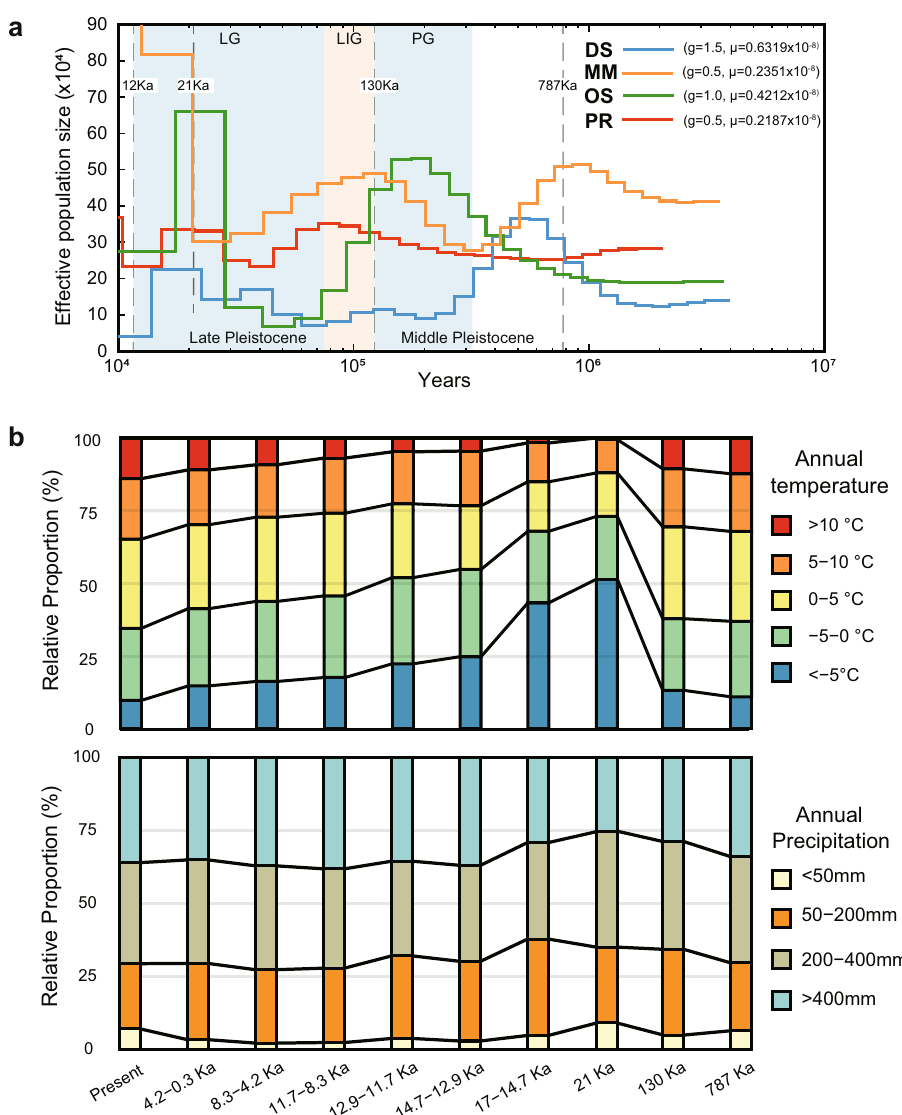
Fig. 5 Demographic history of the four desert rodents during historical climate changes. a Effective population sizes of the four desert rodents reconstructed using the PSMC model (g, generation time, years; μ , neutral mutation rate per generation). The period of the Penultimate Glaciation (PG, 330 – 130 ka), and the Last Glaciation (LG, 75 – 10 ka) are shaded in light blue, and the period of the Last Interglaciation (LIG, 130 – 800 ka) is shaded in light orange. b The relative temporal changes in annual precipitation and annual mean temperature from 787 Ka to present within a de fi ned region (Lat: 33 N, 55 N; Long: 70E, 130E) including the distributions of the four desert species. The annual mean temperature and annual precipitation layers during the Quaternary were downloaded from PaleoClim